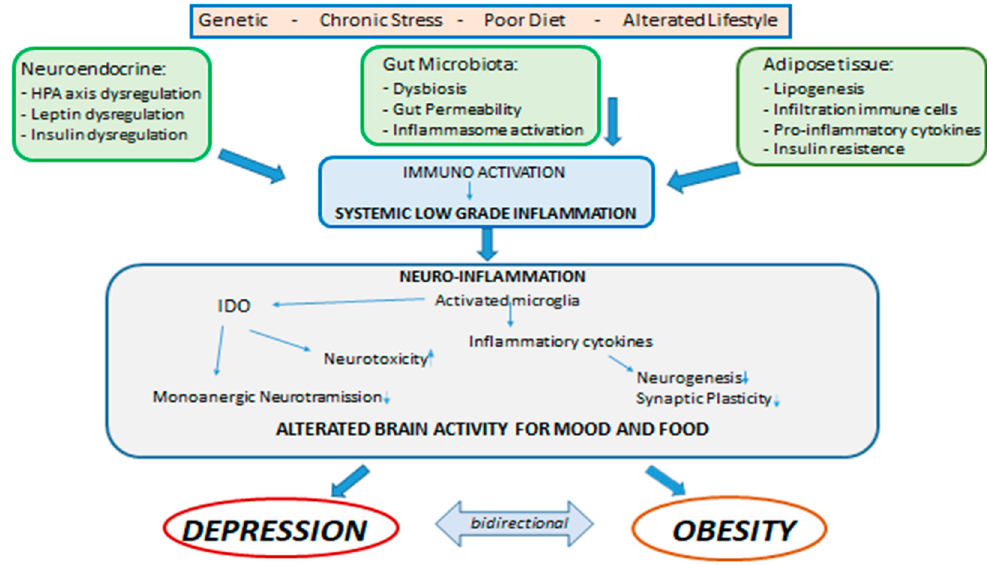
Figure 1. Depression and Obesity: interaction between genetic factors, chronic stress, unhealthy diet and lifestyles.